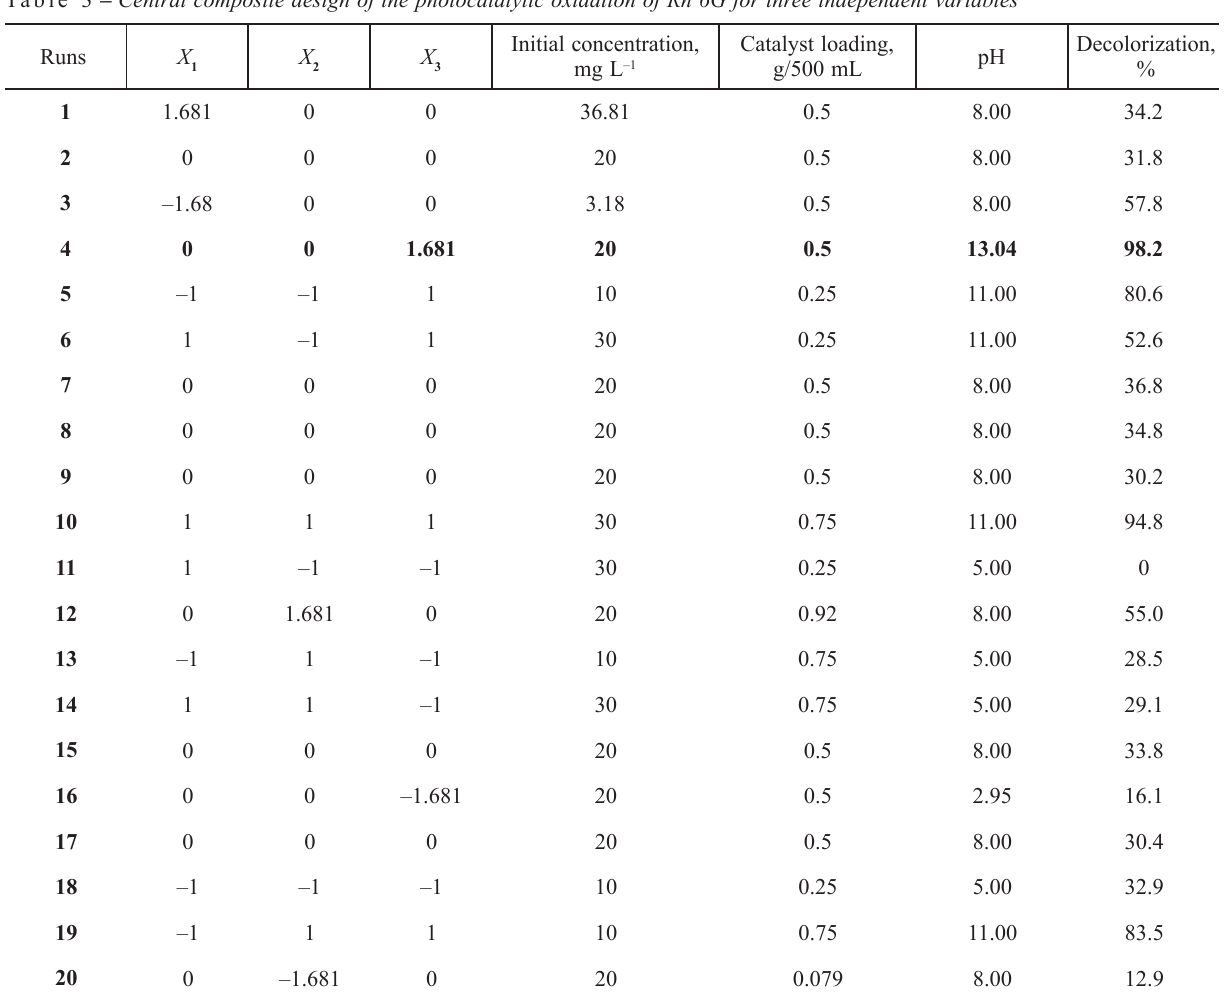
Table 3 – Central composite design of the photocatalytic oxidation of Rh 6G for three independent variables